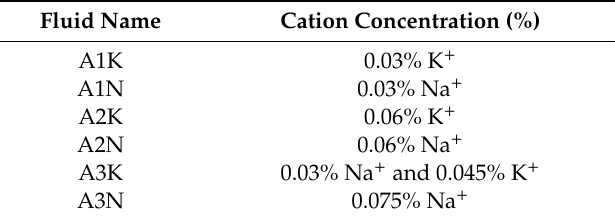
Table 2. Table 1 fluids with cation